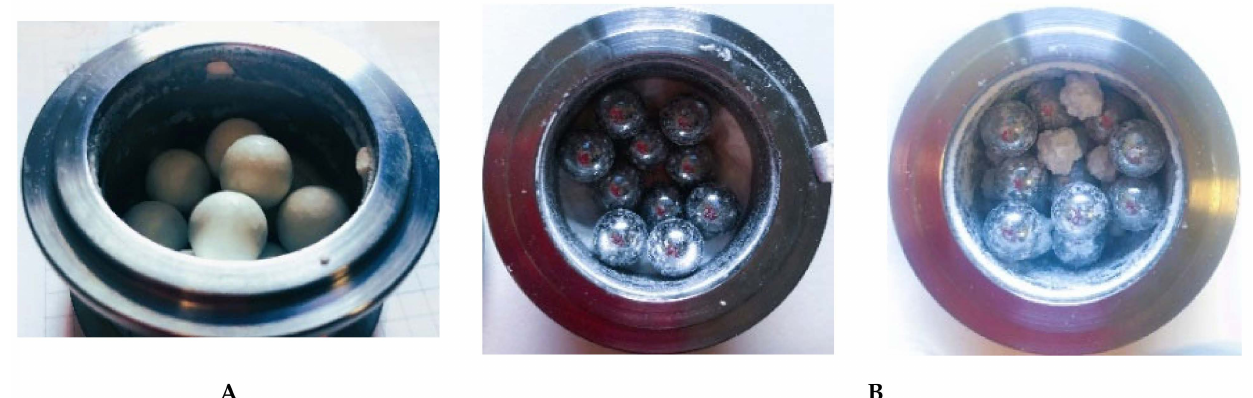
Figure 2. Examples of post-reaction mixture when no additives are used and with the addition of starch or disperal ( A ) post-reaction mixture sticks to the balls, and when additional zeolites ( B ) are used post-reaction mixture is at the bottom of the vessel or it additionally forms dense lumps, only a few balls are sticky.